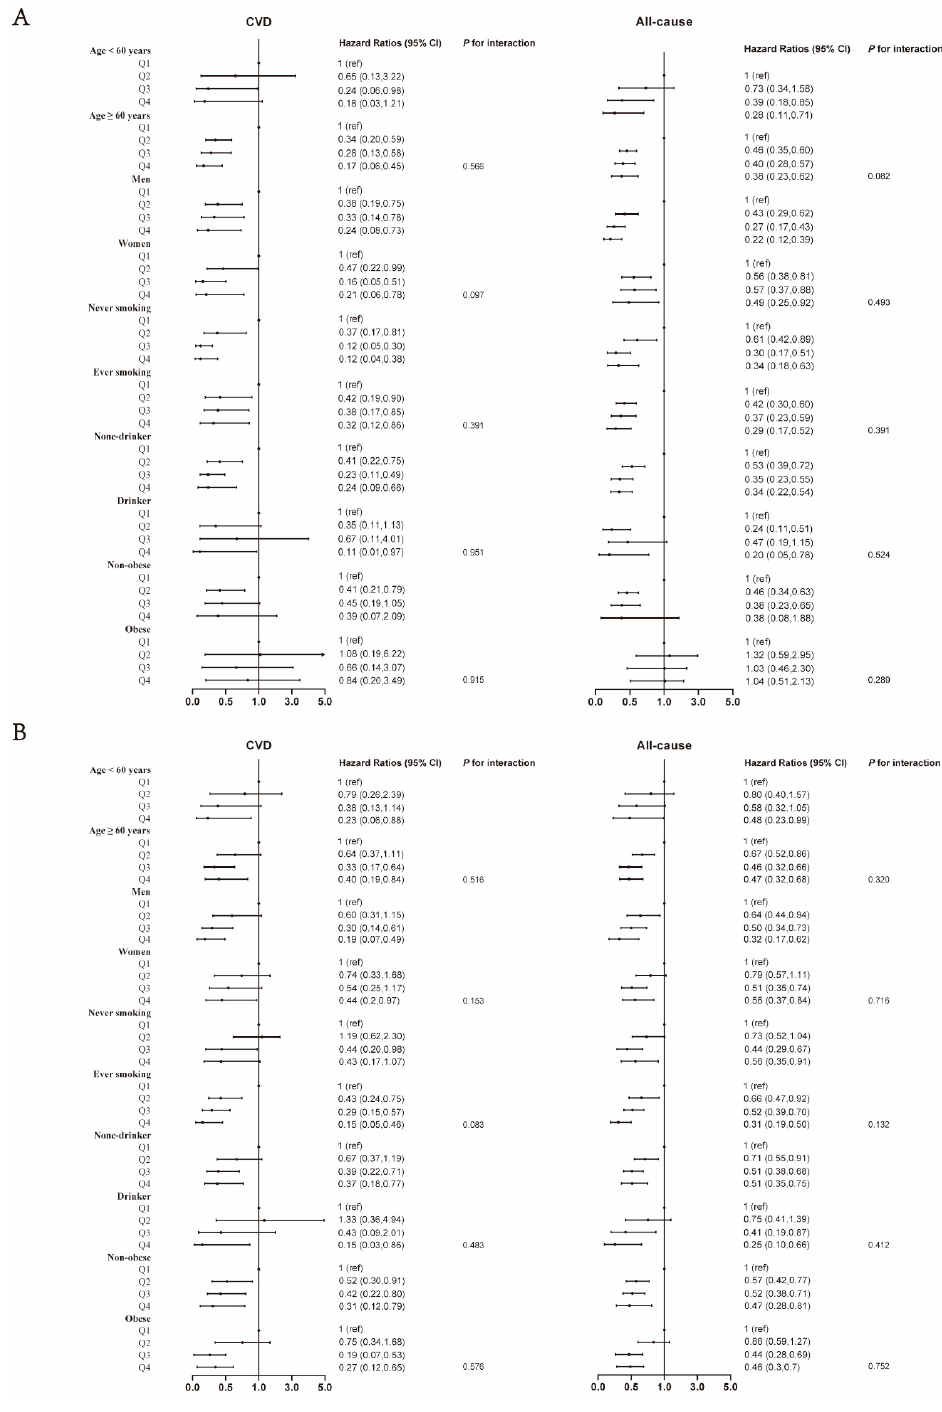
Figure 2. Associations between AC ( A ), AC/WC ( B ), and risk of CVD, with all-cause mortality stratified by age, gender, alcohol drinking status, smoking status, history of hypertension. HRs were adjusted for age (not adjusted in subgroup analysis by age), gender (not adjusted in subgroup analysis by gender), race/ethnicity, education, alcohol drinking (not adjusted in subgroup analysis by alcohol drinking), BMI (not adjusted in subgroup analysis by BMI), total cholesterol, high-density lipoprotein cholesterol, carbohydrate intake, dietary fiber intake, fasting glucose, history of hypertension, and history of dyslipidemia, history of cancer, self-reported